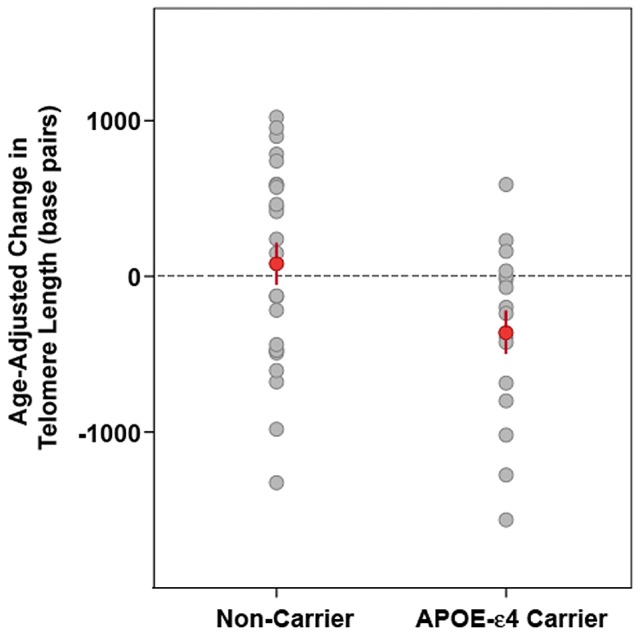
APOE-ε4 genotype and telomere attrition.Dot plot illustrating age-adjusted change in leukocyte telomere length (TL) in carriers of the APOE-ε4 risk allele and non-carrier controls. APOE-ε4 carriers had significantly greater age-adjusted LTL shortening over the 2 year study period than non-carrier control participants [F(1,39) 4.89, p = .03].